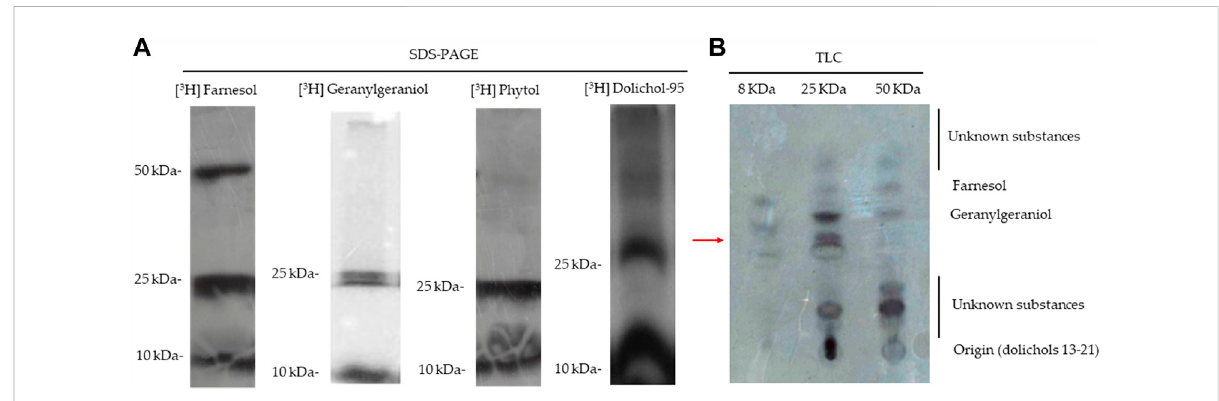
FIGURE 4 SDS-PAGE and iodomethane treatment of prenylated proteins. (A) SDS-PAGE analysis of [ 3 H] GGOH, [ 3 H] FOH, dolichol-95, and POH-labeled proteins of P. falciparum . (B) Substances released from the cleavage with methyl iodide of the three protein clusters incorporate [ 3 H] FOH; (autoradiography of a TLC analysis). The chromatographic retention of several isoprenoid alcohol standards is indicated in the fi gure. Red arrow: Rf of